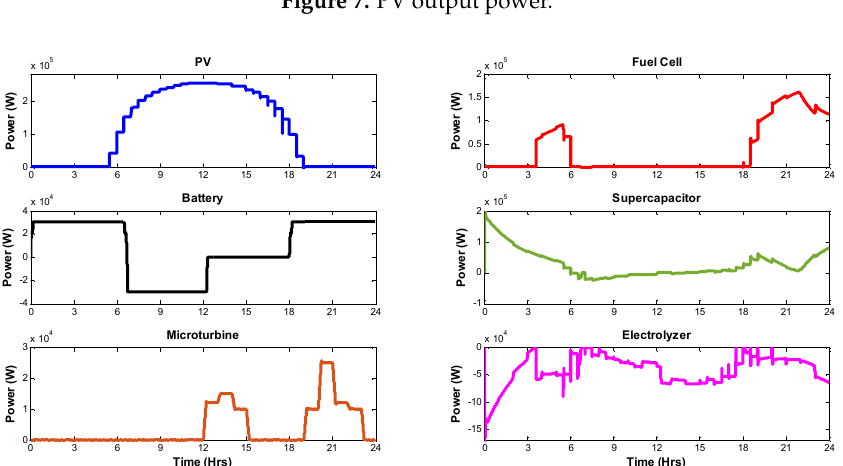
Figure 8. Individual powers of RESs.